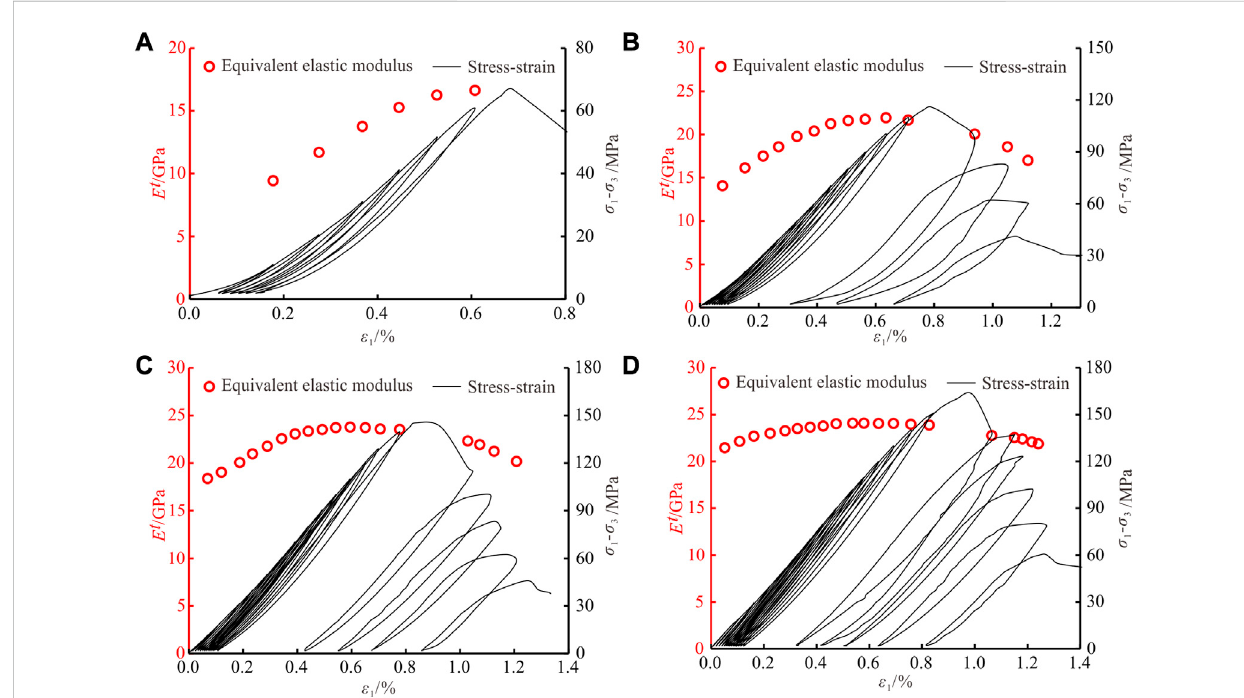
FIGURE 6 Equivalent elastic modulus under different con fi ning pressure. (A) Relationship between equivalent elastic modulus and deviatoric stress. (B) Quadratic polynomial fi tting of equivalent elastic modulus.